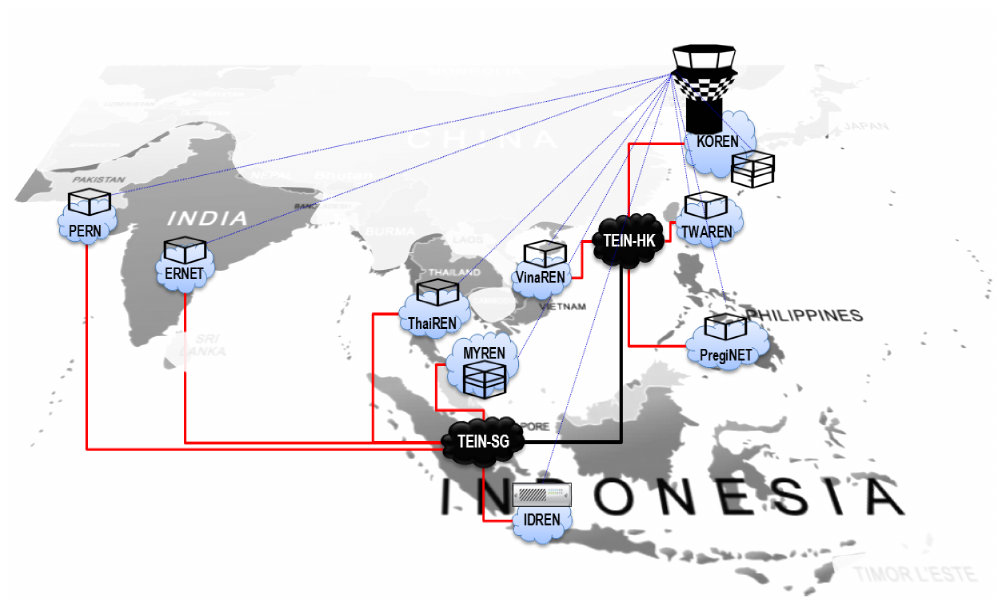
Figure 2. OF@TEIN